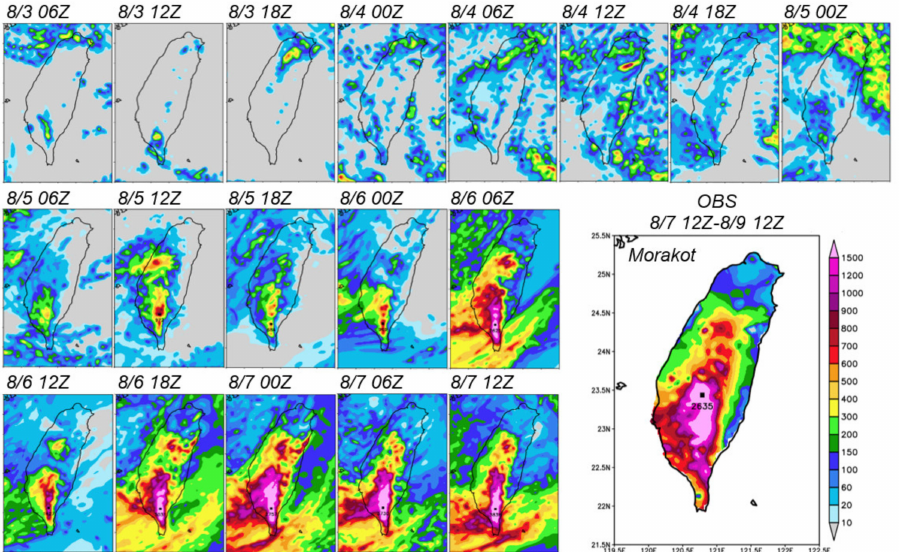
Figure 4. The observed 48-h rainfall (mm, enlarged panel), from 1200 UTC 7 to 1200 UTC 9 August during TY Morakot (2009) and the predicted rainfall (mm) targeted for the same period by the time- lagged ensemble every 6 h (smaller panels), at initial times from 0600 UTC 3 to 1200 UTC 7 August as labelled. The same color bar (lower right) is used for all panels, and the maximum amount is marked in the observation and hindcasts starting at 1200 UTC 5